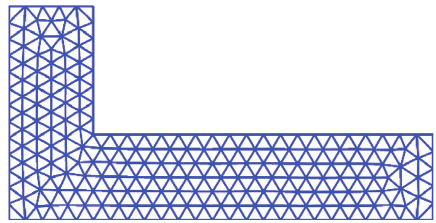
Figure 7: Domain discretization using triangular.